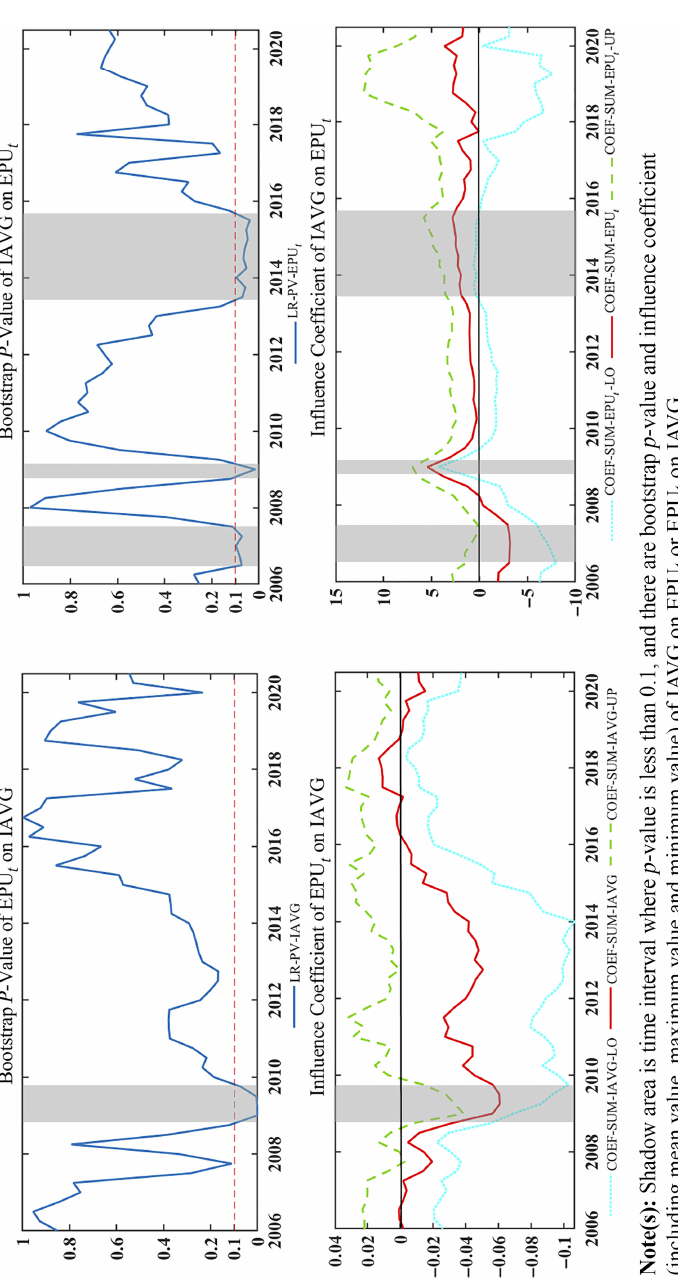
Figure 5. Sub-sample bootstrap rolling window causality test of EPU t and